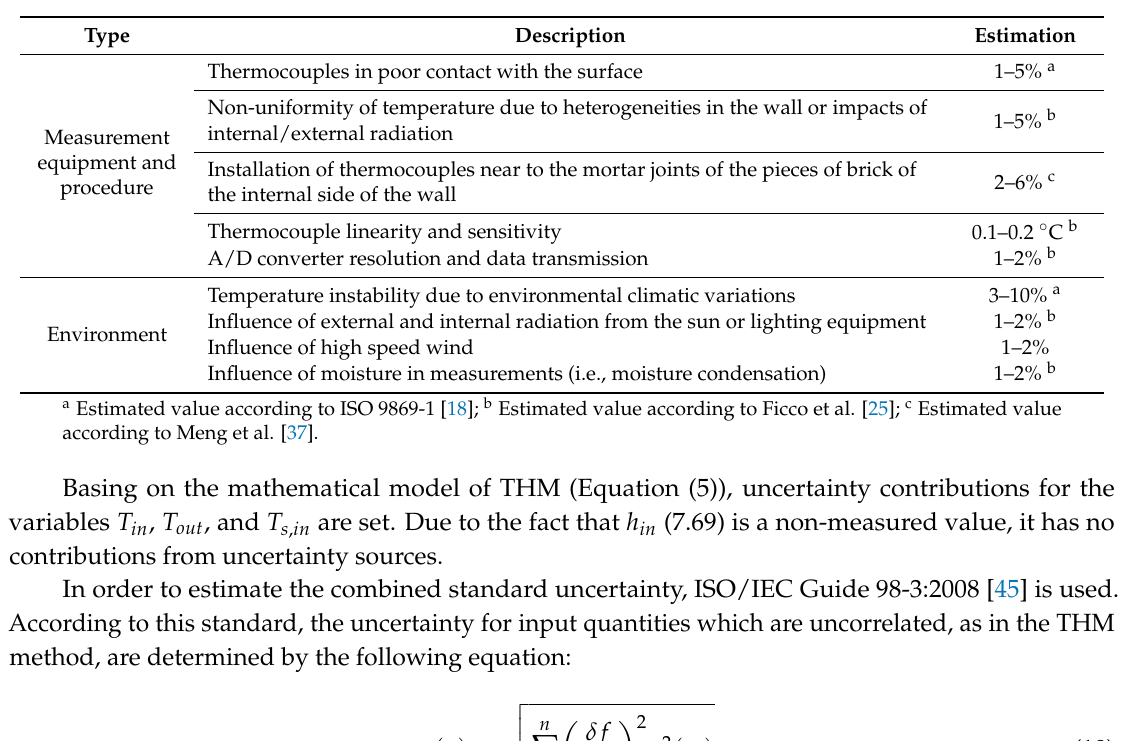
Table 1. Uncertainty contributions estimated by the